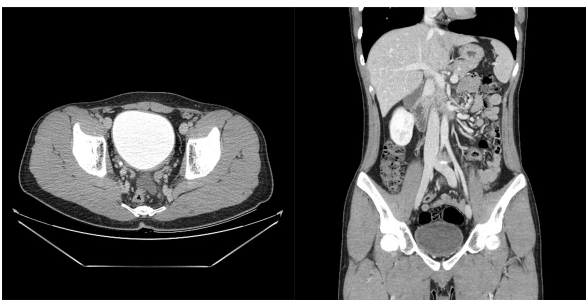
Fig. 5. Computed tomography at 1 year postoperatively . There were no specific findings other than thickening of the bladder wall around the left ureterovesical junction where the ureterocele had been